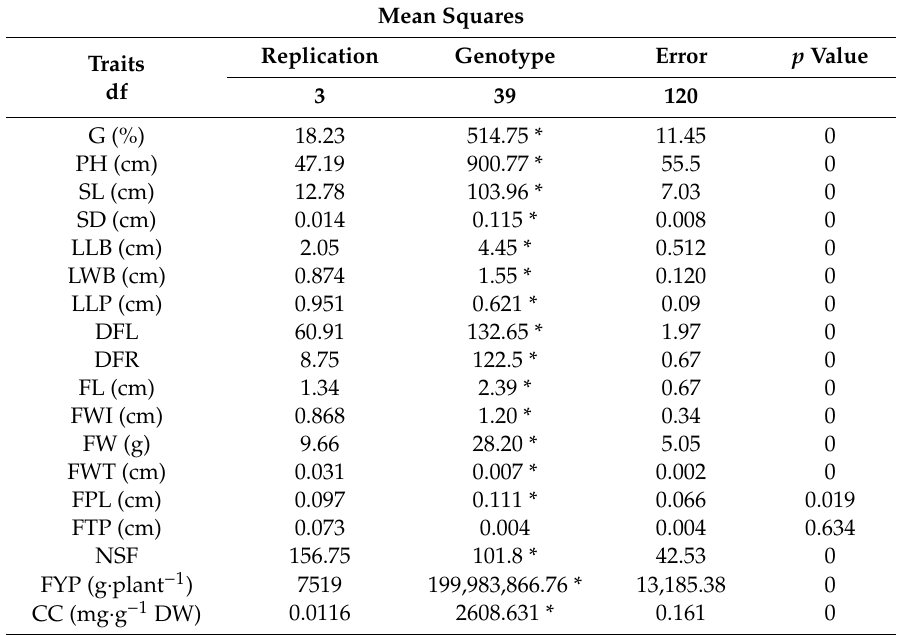
Table 4. Analysis of variance (ANOVA) of the quantitative traits of the evaluated genotypes of habanero pepper. Mean Squares Replication Traits df